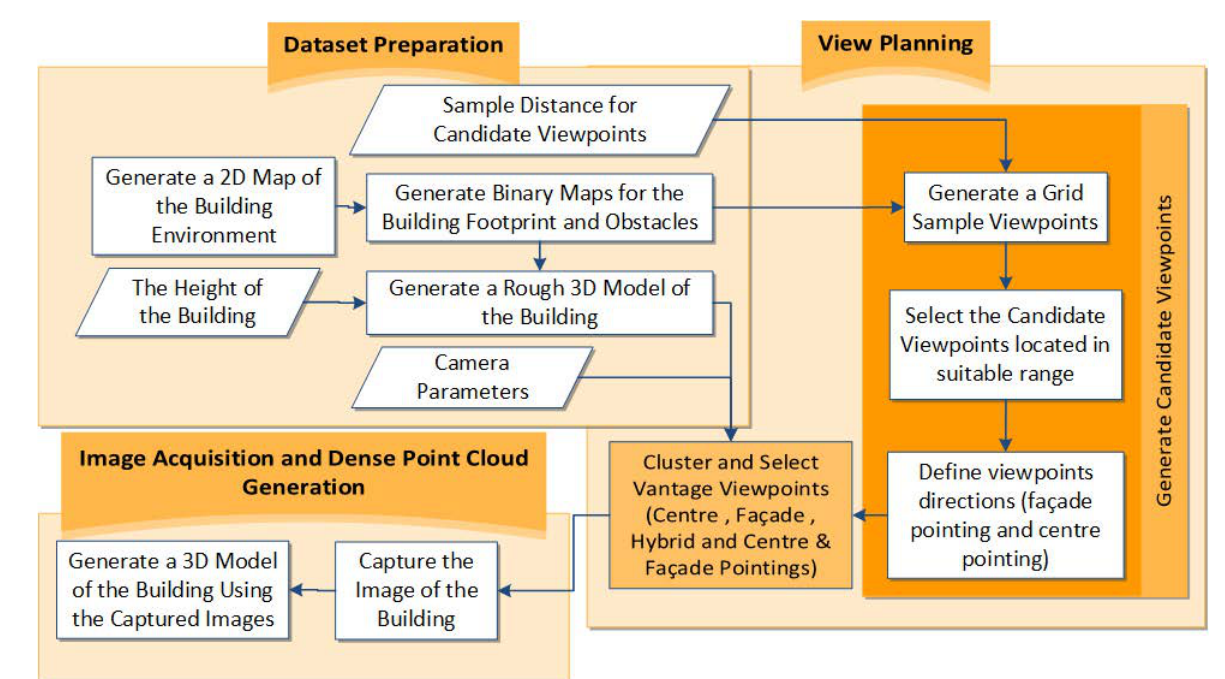
Figure 1. The proposed methodology for imaging network design for image-based 3D reconstruction of